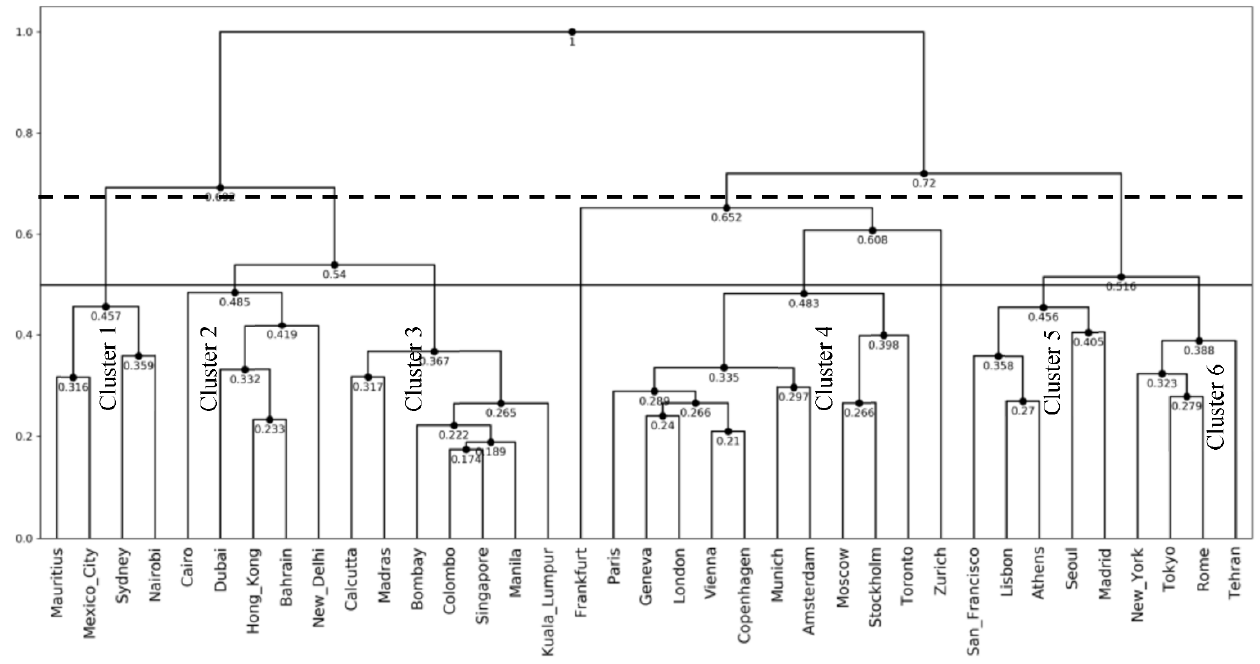
Figure 14. Dendrogram for 12 months.